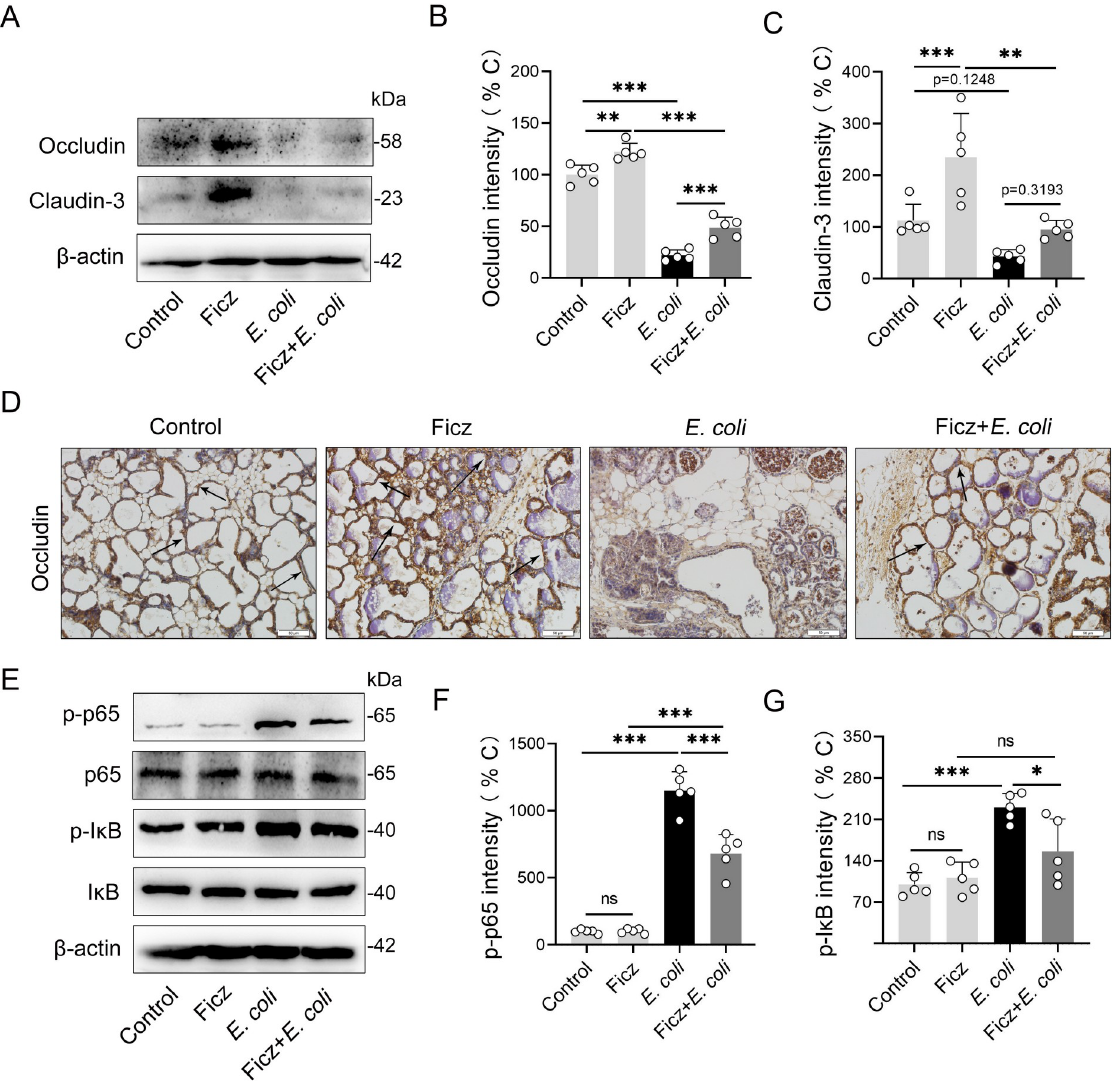
Fig 2. AhR activation by Ficz improves barrier integrity and limits inflammatory signaling in mice with E . coli -induced mastitis. Mice were treated with or without Ficz (1 μ g/mouse) intraperitoneally 1 h before the E . coli was applied (10 7 CFU/50 μ L each breast duct). Twenty-four hours later, the mammary gland tissues were harvested and detected. ( A-C ) The levels of tight junction proteins, including occludin and claudin-3, in mammary glands were detected using western blots (n = 5). ( D ) Representative images of mammary gland immunohistochemistry (IHC) sections stained with occludin antibody (scale bar, 50 μ m). The black arrow indicates the positive staining. (E-G ) Protein levels of the NF- κ B signaling pathway, including phosphorylated p65 and I κ B, as well as p65 and I κ B, which were measured by western blotting (n = 5). One-way analysis of variance was applied for statistical analysis of ( B-C) and ( E-F) and the date are presented as means ± SEM. � p < 0.05, �� p < 0.01 and ��� p < 0.001 mean significant differences from each group. ns, no significance. Ficz on E . coli growth and found no significance (S1D Fig). To verify the effects of AhR activa- tion on E . coli -induced mastitis, we inhibited AhR activation by pretreating mice with CH223191, an AhR antagonist. We showed that CH223191 treated mice had higher inflamma- tory responses than E . coli -treated mice (S2A–S2E Fig). Similar studies have also demonstrated that treating with CH223191 exacerbated calcipotriol-induced dermatitis and colitis [19,35]. Likewise, the Ficz improvement of inflammatory features caused by E . coli was reversed by CH223191 pretreatment (S2A–S2E Fig), suggesting that inhibiting AhR signaling could